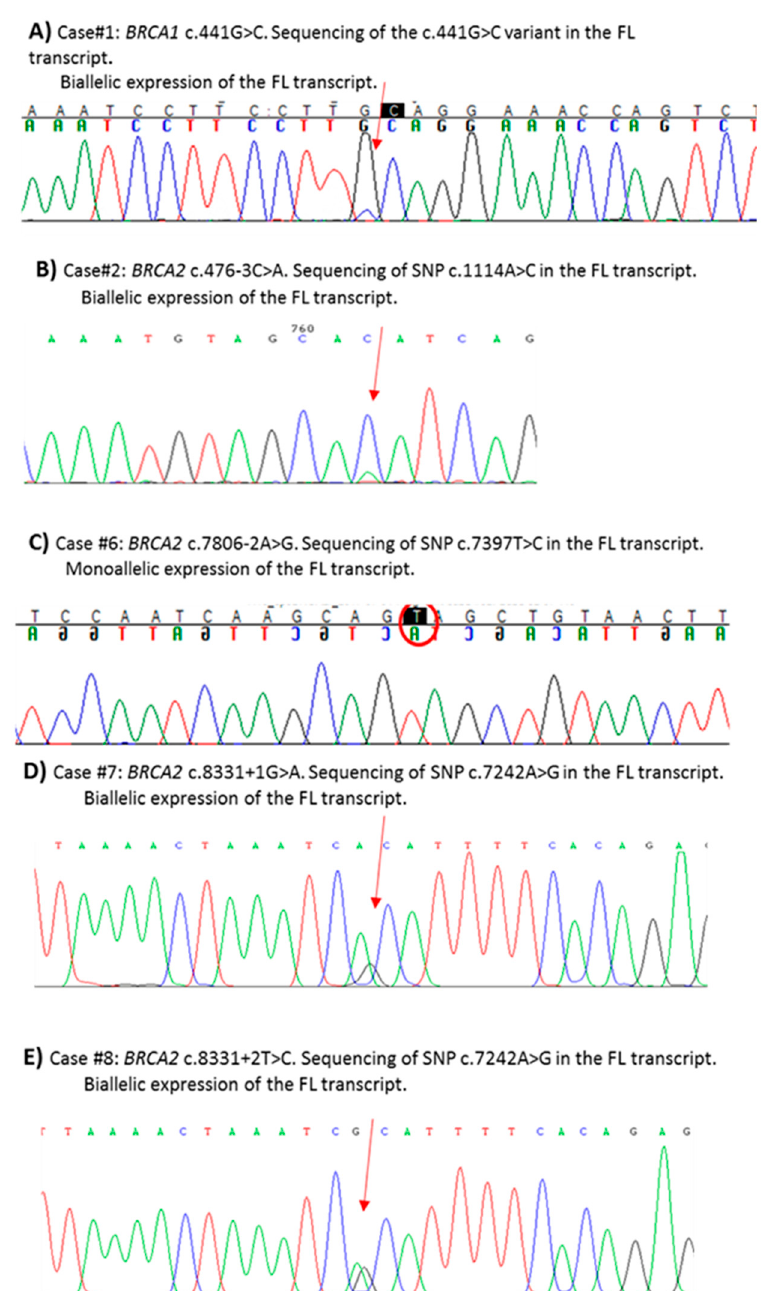
Figure 4. Determination of partial/total effect by SNP Sanger sequencing in the full-length (FL) transcripts from PAXgene samples (panel A ) or LCLs (panels B , C , D , and E ). Primers are shown in Supplementary Table S3. The arrows indicate the investigated SNPs.